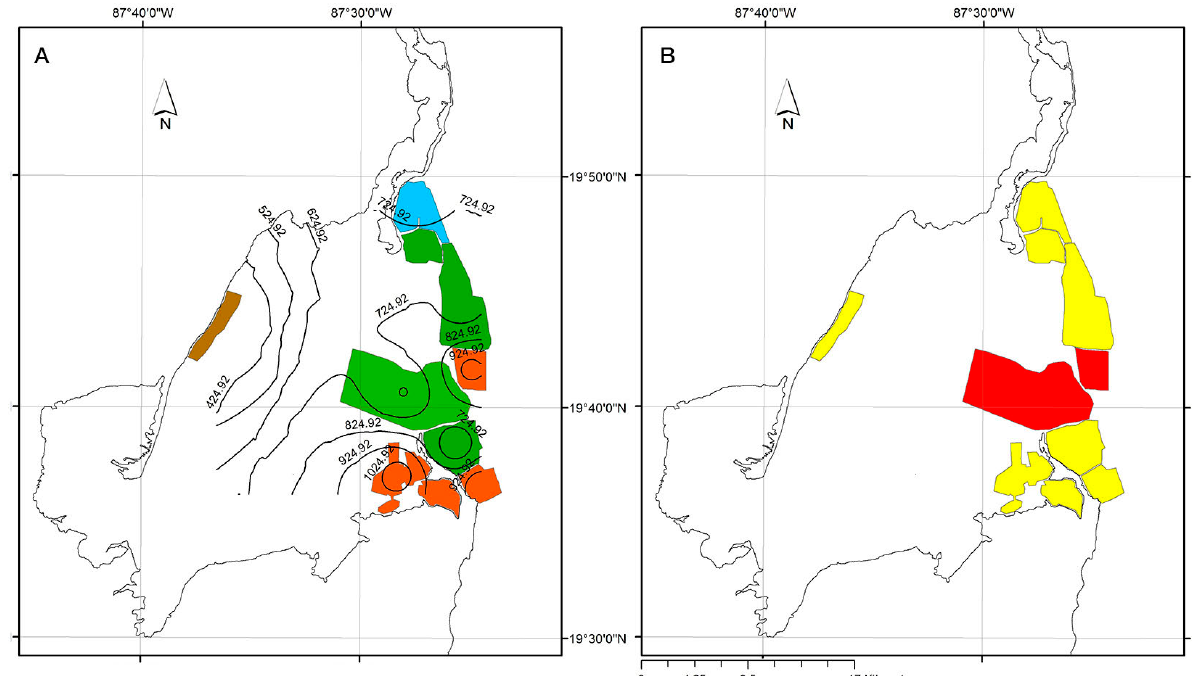
Fig. 7. – A, four homogenous groups of fishing areas (orange, blue, green and brown) and isolines for the mean quasi-profit of variable costs per trip (USD) identified using a Tukey HSD test; B, fishing areas with significant interactions between seasons (red) and without (yellow) of mean quasi-profits of variable costs per trip (USD) identified using a Tukey HSD